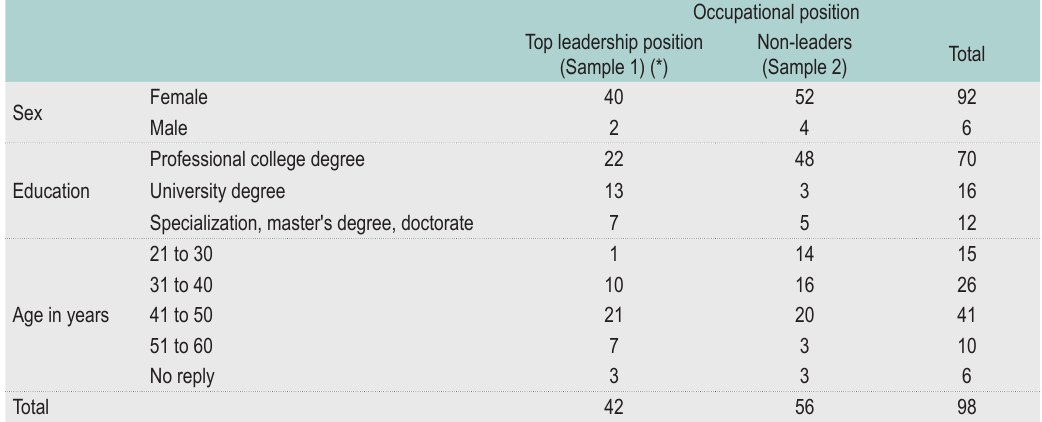
(*) head nurses and their assistants and clinic